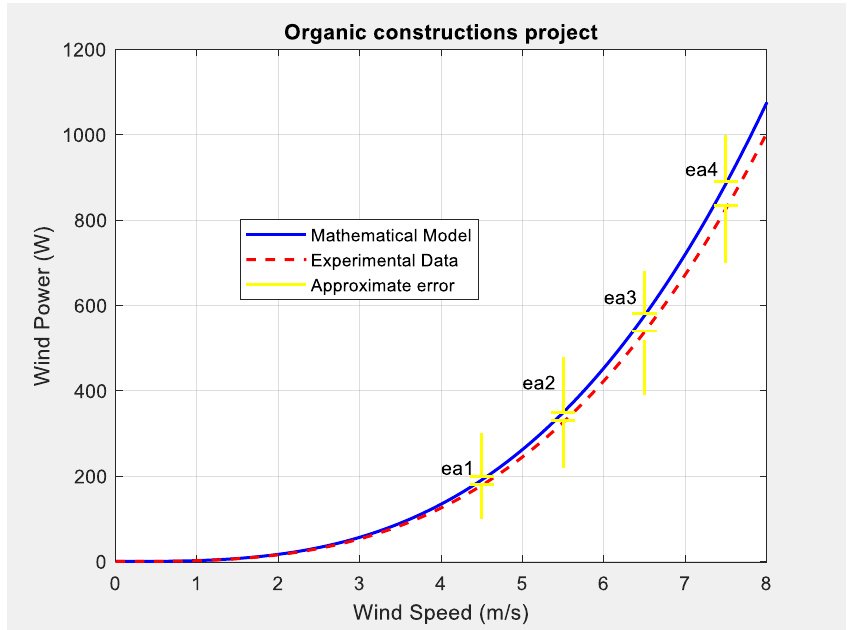
Figure 24. Referential graph for the estimation of errors between the mathematical model and the experimental curve of the wind turbine.